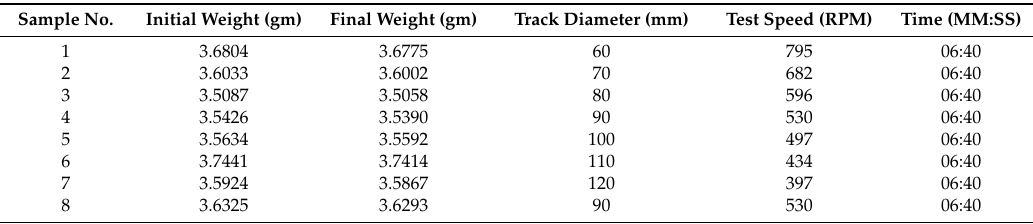
Table A3. Wear loss of samples (Sliding Velocity: 2.5 m/s, Load: 40 N, Sliding Distance: 1000 m). Sample